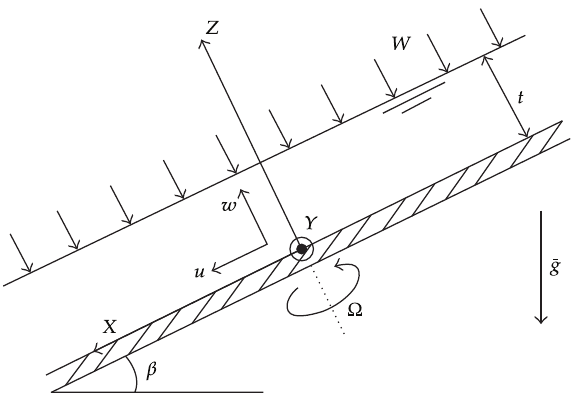
Figure 1: The schematic diagram of steady three-dimensional problem of condensation film on inclined rotating